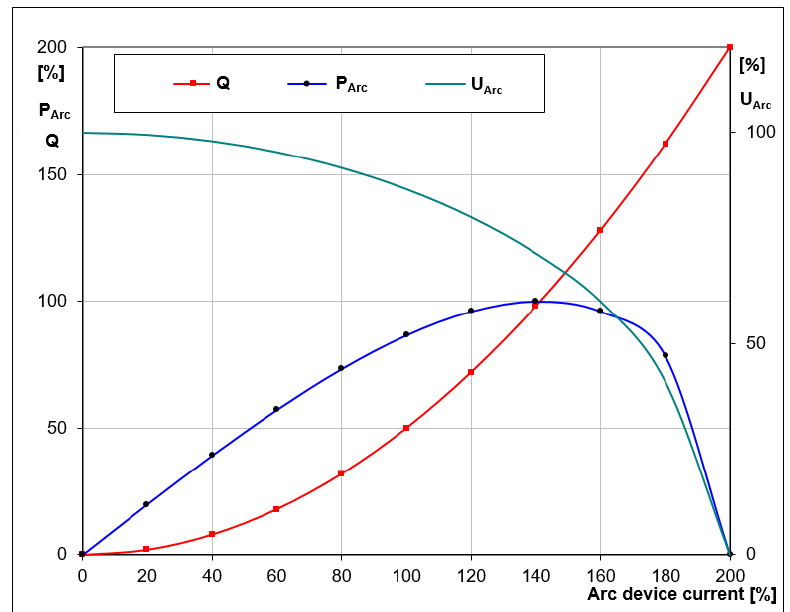
Figure 9. Operating characteristics of an ideal arc device: ( U ′ SV = 100%, X = 50%, R = 0). In the event of changes in the supply voltage (from the value of U ′ SV to the value of U ″ SV ), but while maintaining constant arc voltage, the arc current as well as the active and reactive power change.